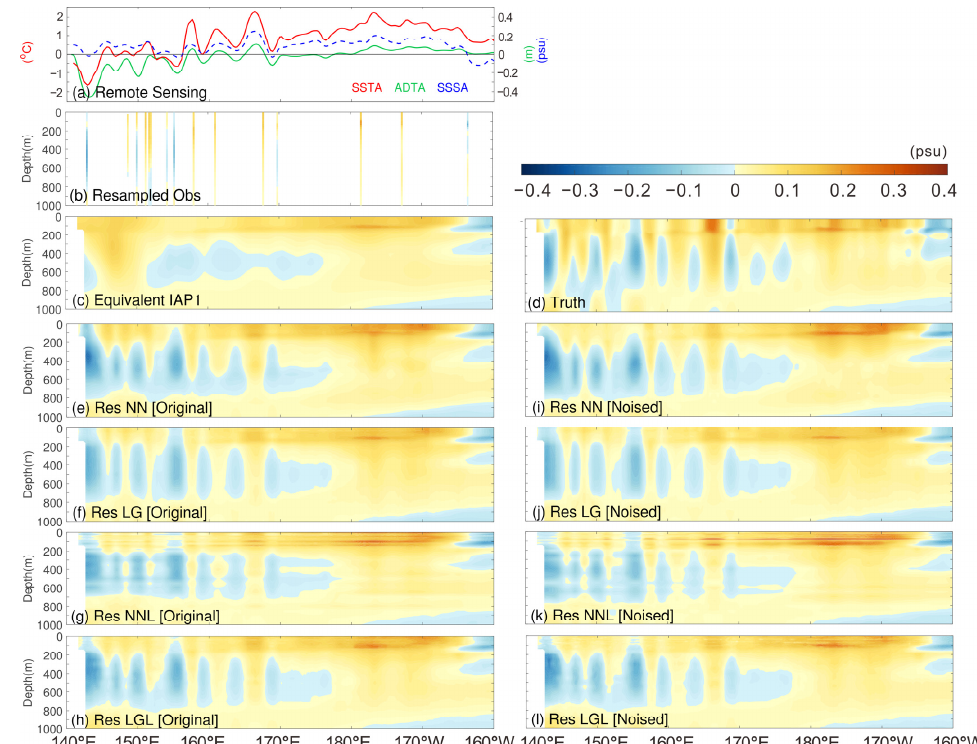
Figure 7. ( a ) Distribution of synthetic remote sensing: SSTA (left y axis), ADTA (right y axis), and SSSA (right y axis) at the sea surface. The vertical section along 35.375°N in the Kuroshio and its extension region of ( b ) resampled salinity anomalies according to in situ observation, ( c ) equivalent IAP1° subsurface salinity anomalies, ( d ) truth value, ( e – h ) reconstructed data from experiments per- formed with the original synthetic dataset, and ( i – l ) reconstructed data from experiments performed with the noised synthetic dataset. The fields for January 2016 are shown. Reconstructed data ob- tained from experiments on the original synthetic dataset The salinity reconstructed by Case NNL exhibits a pronounced, discontinuous, lay- ered vertical structure for the original synthetic dataset (Figures 6g and 7g). For the noised synthetic dataset, the salinity reconstructed by Case LGL also exhibits a discontinuous, layered vertical structure (Figures 6l and 7l). This indicates that Case NNL and Case LGL do not adequately reflect the vertical structure of salinity fields. Furthermore, the discon- tinuous, layered vertical structure is more pronounced in the 1–200 m depth range be- cause this range is divided into 17 standard layers with smaller intervals between the lay- ers. In the pre-Argo period, the discontinuous, layered vertical structure was more pro- nounced because of fewer in situ observations. Figure 8 shows the vertical structure in the Gulf Stream region in January 1998 when in situ observations were not available in the Gulf Stream region. The salinity reconstructed by Case NNL and Case LGL exhibits ver- tical discontinuities in the entire Gulf Stream region and the 50–70°W region, respectively (Figure 8a,b). The addition of noise to the truth values made these vertical discontinuities even more pronounced (Figure 8f,g). In contrast, the data reconstructed by Case NN and Case LG do not exhibit such phenomena. This can be attributed to Case NNL and Case